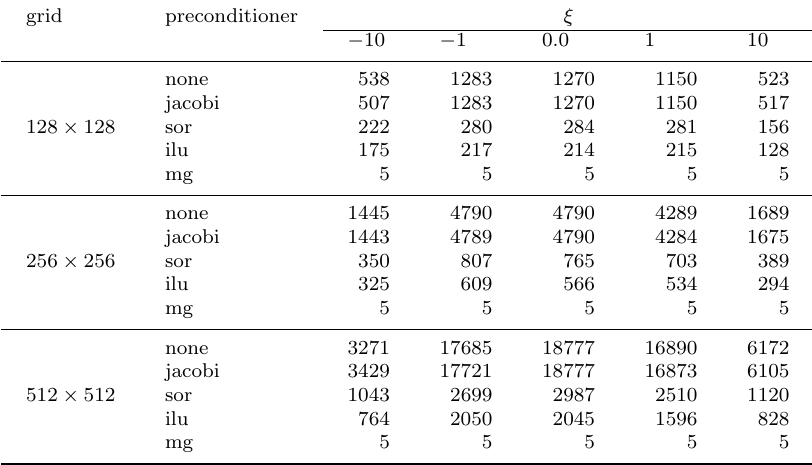
Table 2. The number of iterations for different preconditioners depending on the grid